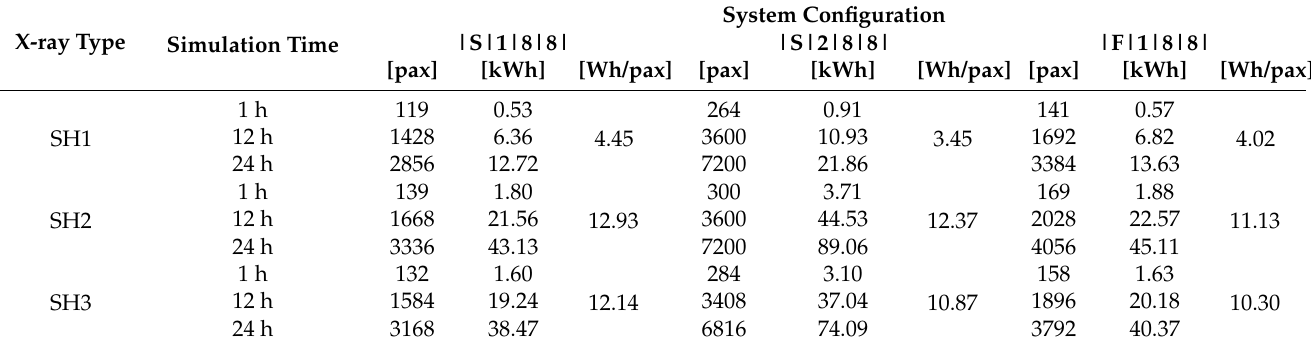
Table 4. Computer simulation results for given system